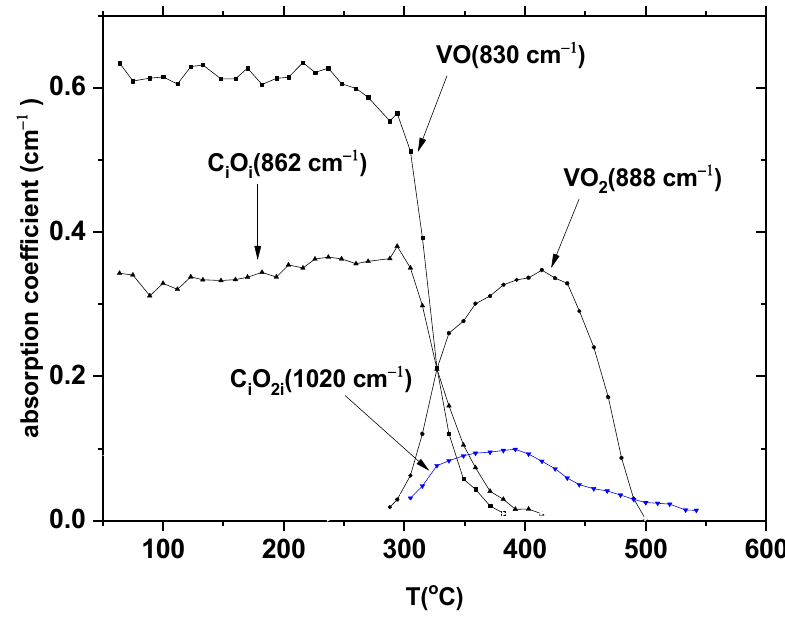
Figure 2. The thermal evolution of the 830 cm − 1 (VO), 862 cm − 1 (C i O i ), 888 cm − 1 (VO 2 ), and the 1020 cm − 1 band.